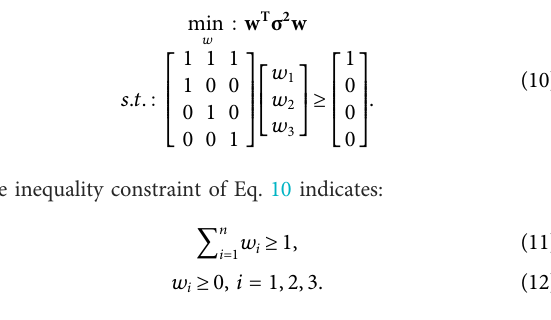
Table 1. Three GMMs were developed using stochastic